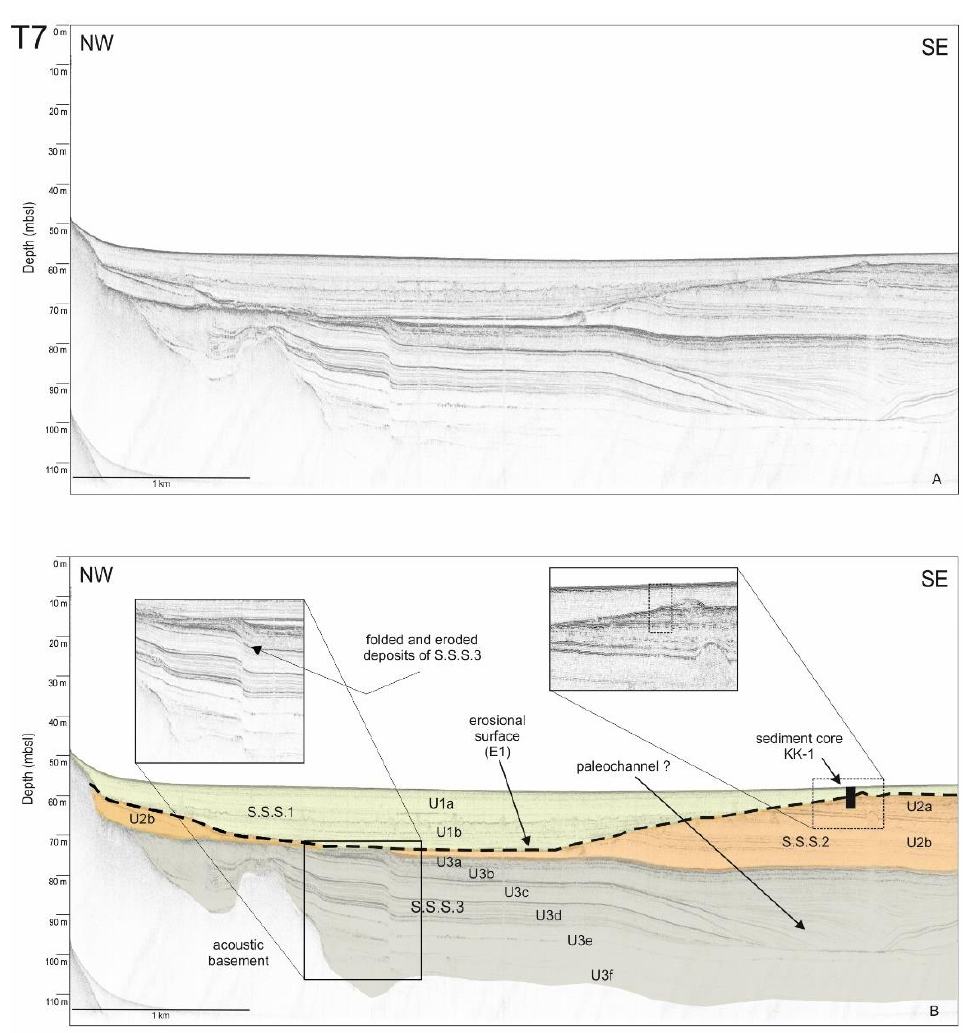
Figure 5. ( A ) High-resolution seismic profile of seismic line T7 and ( B ) its stratigraphic interpretation with sediment core. The location of the line is shown in Figure 1.